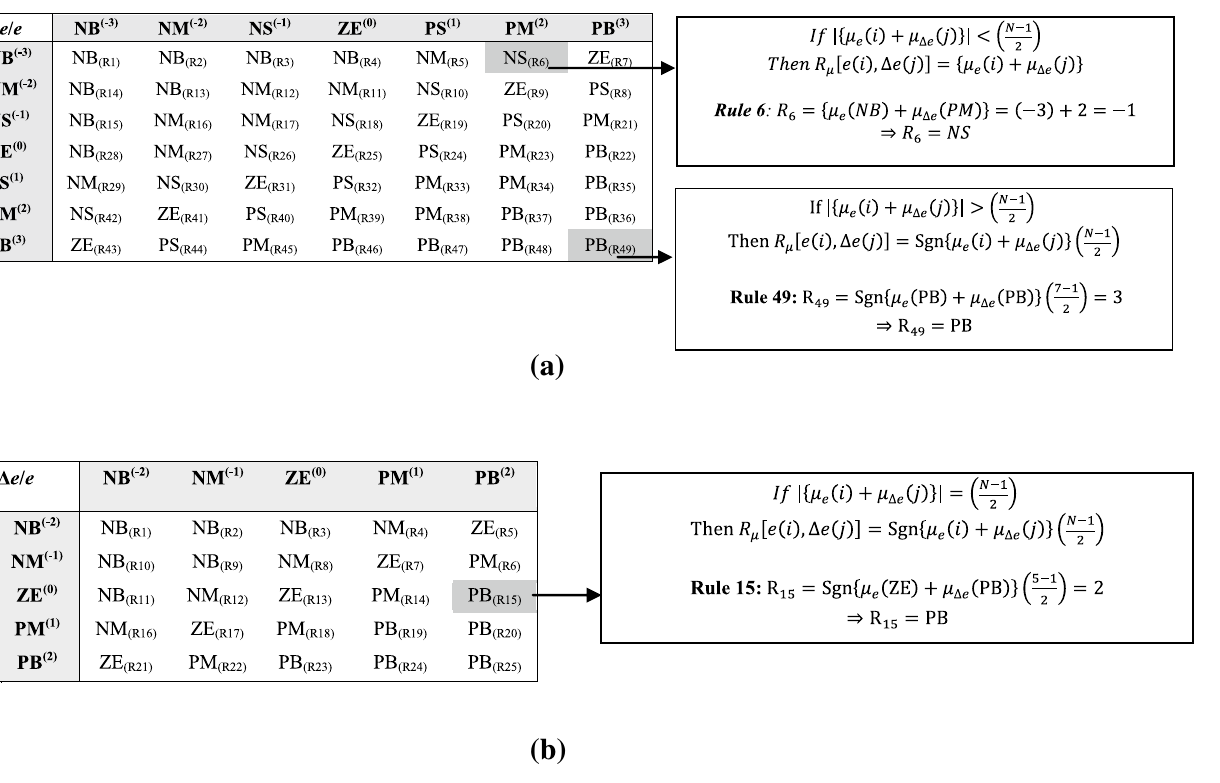
Fig. 2 Rule bases for computation of Δ u ∕ u with a 49 rules, b 25 rules, and the corresponding rule generation